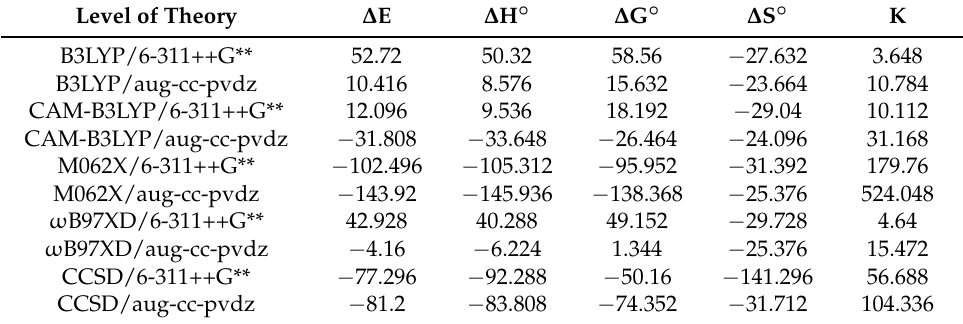
The zero-point total energy ( ∆ E/kJ · mol − 1 ), enthalpy ( ∆ H/kJ · mol − 1 ), free energy tautomerization reaction: 2-PY ↔ 2-HPY at 298.15